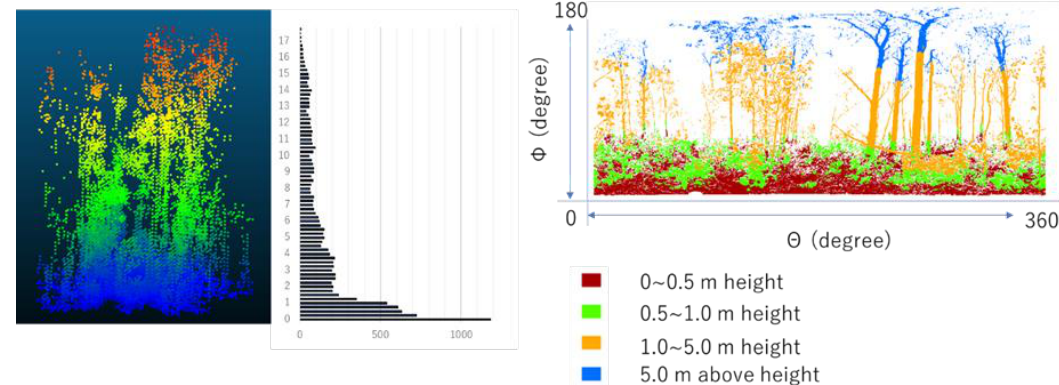
Figure 3. Vertical voxel distribution and counting in orthogonal coordinate (left) and human vision-oriented image in spherical coordinates (right).